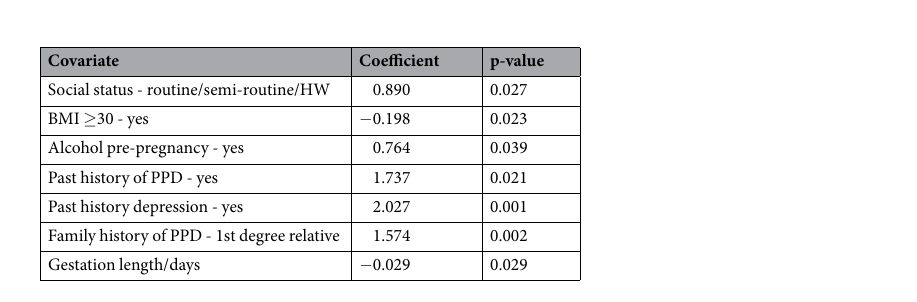
Table 7. Significant covariates of a linear model for average antenatal and postpartum (APA) EPDS scores. The full model is provided in Suppl. Table 7.